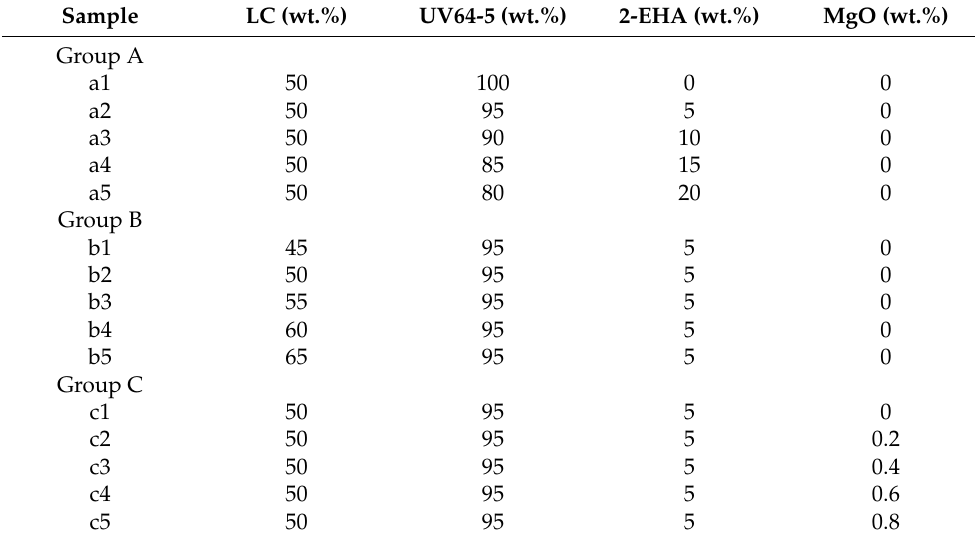
Table 2. The compositions of the